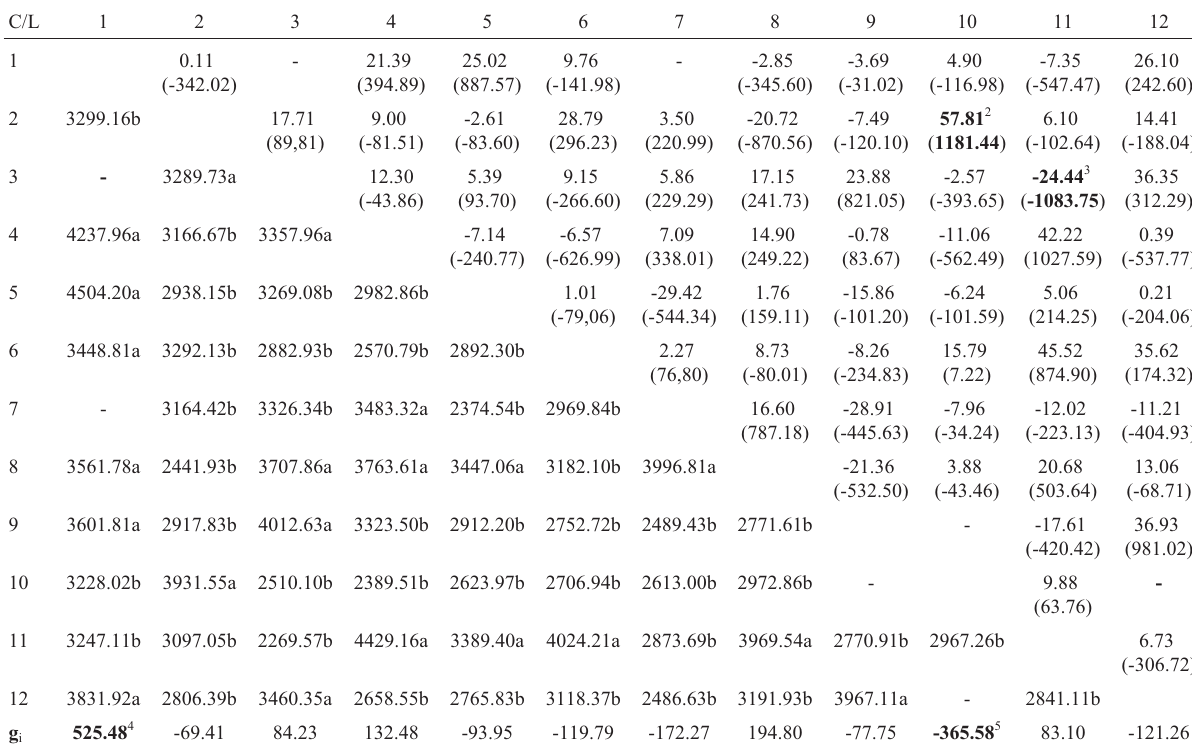
Table IV - Estimates of heterosis (%), specific combining ability s ij (between parentheses, above the diagonal), mean grain yield (kg/ha) (below the diagonal), and general combining ability (g i ).